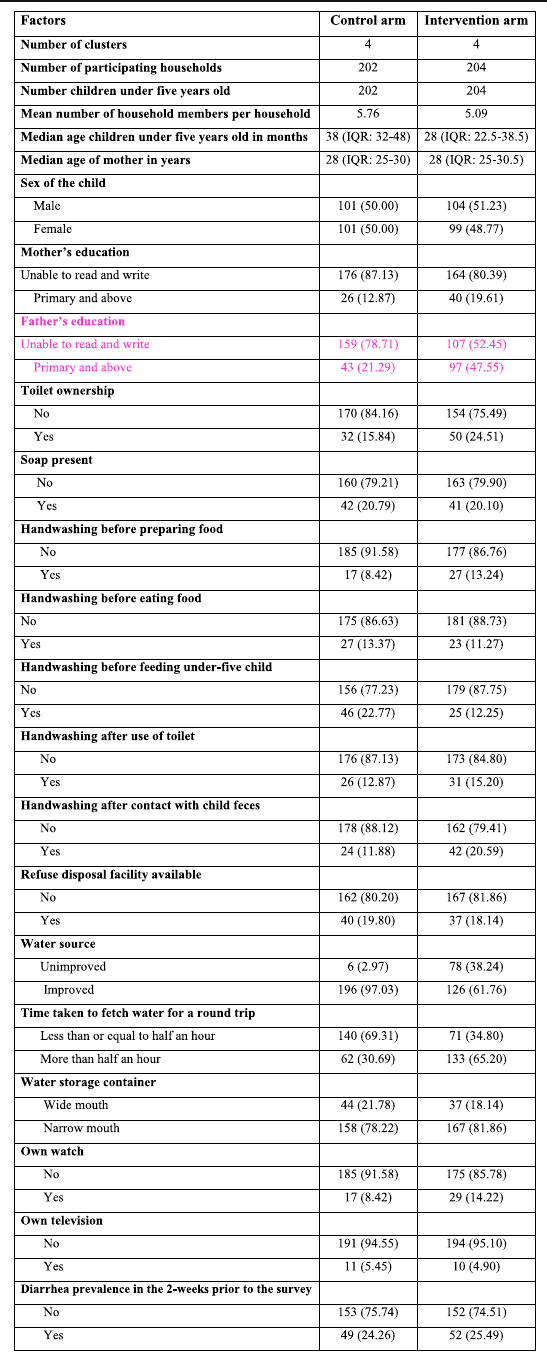
Table 1 Socio-demographic, behavioral, and environmental variables and pre-intervention diarrhea of control and intervention groups at baseline, rural kebeles of Dire Dawa,